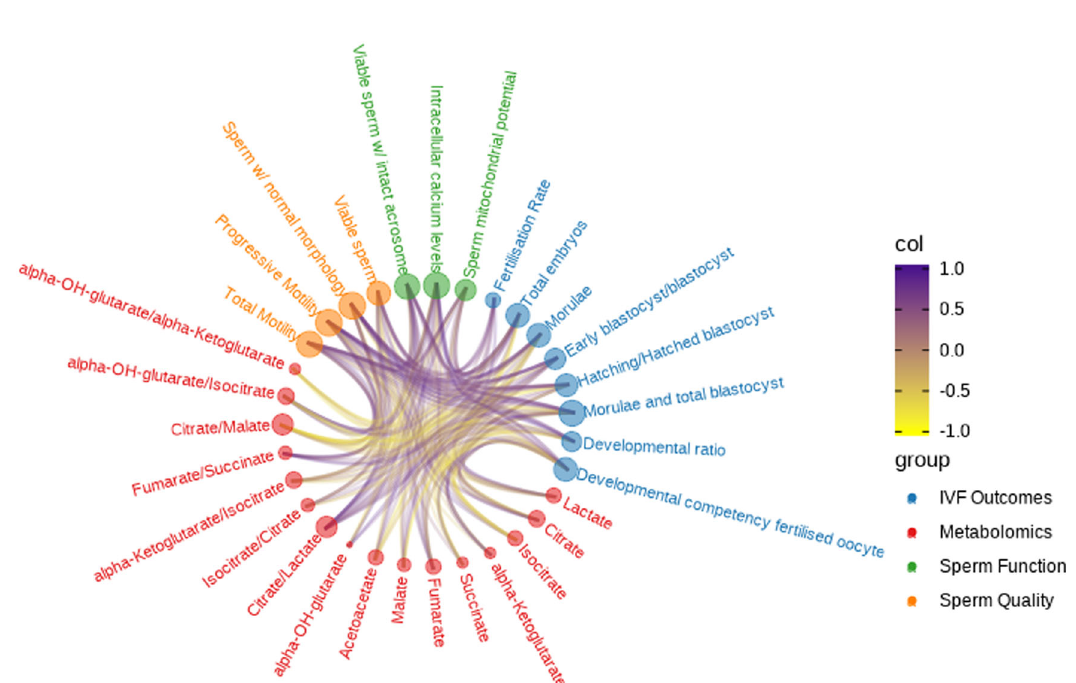
Fig. 2 Integrative network graph depicting correlations derived from the N-integration with projection to latent structures between blocks. In vitro fertilisation outcomes (blue), metabolomics (red), sperm function (green) and sperm quality (orange) were associated on the basis of a similarity score > | 0.3| ( n = 15). Lines are coloured according to similarity scores: positive associations are shown in purple, whereas inverse associations are depicted in yellow. Nodes (circles) represent variables and are sized according to the number of connections. Further information can be found in Supplementary Table 3. col colour, IVF in vitro fertilisation, OH isocitrate, α -hydroxyglutarate/ α -ketoglutarate and α -ketoglutarate/ similarity scores from multi-block data integration are shown in citrate exhibited a negative relationship. Interestingly, these Supplementary Table 3. The general trend was that whereas citrate, associations were found to be inverse in the case of sperm function isocitrate and citrate/malate showed a positive association with parameters. sperm quality and in vitro fertility blocks, α -hydroxyglutarate/